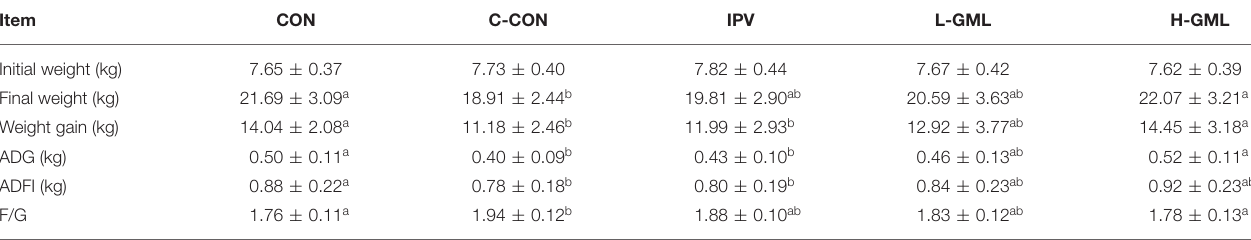
TABLE 3 | The effects of different treatments on growth performance of weaned piglets. Item